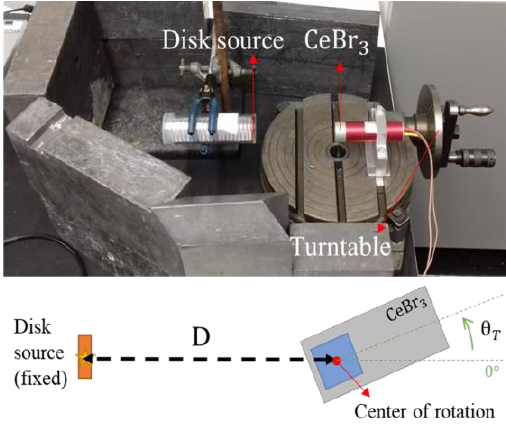
Figure 8 – Experimental setup applied to study the angular dependence of the